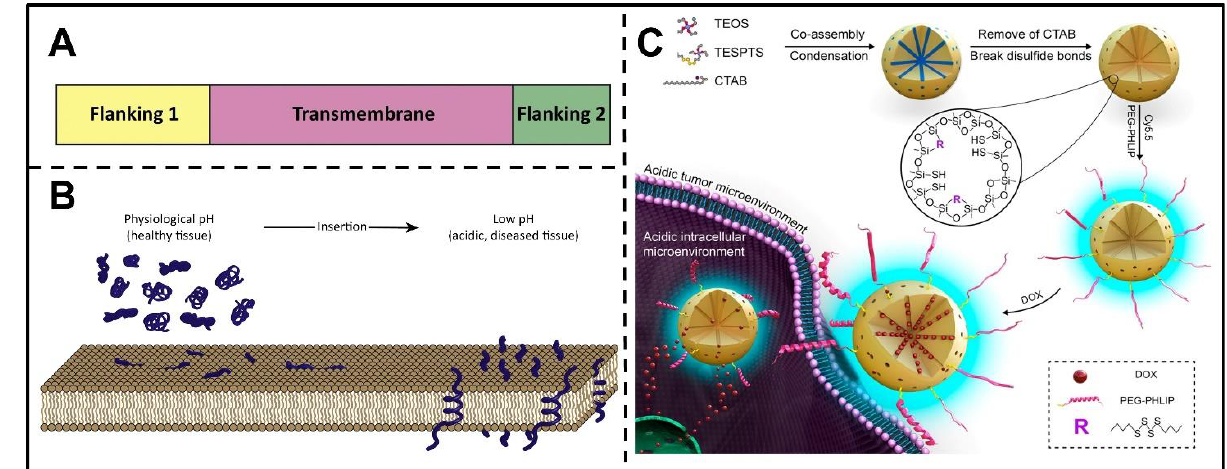
Figure 2. Schematic representing structure and pH-sensitive transmembrane mechanism of pHLIP. ( A ) The main features of three sequences of pHLIP. ( B ) Schematic model of membrane interaction at physiological pH and insertion at low pH of pHLIP. Reproduced with permission [83]. Copyright 2017, Elsevier. ( C ) Preparation of pHLIP-modified MONs and their targeting cancer therapy by pH-triggered transmembrane behavior. Reproduced with permission [81]. Copyright 2017, American Chemical Society.